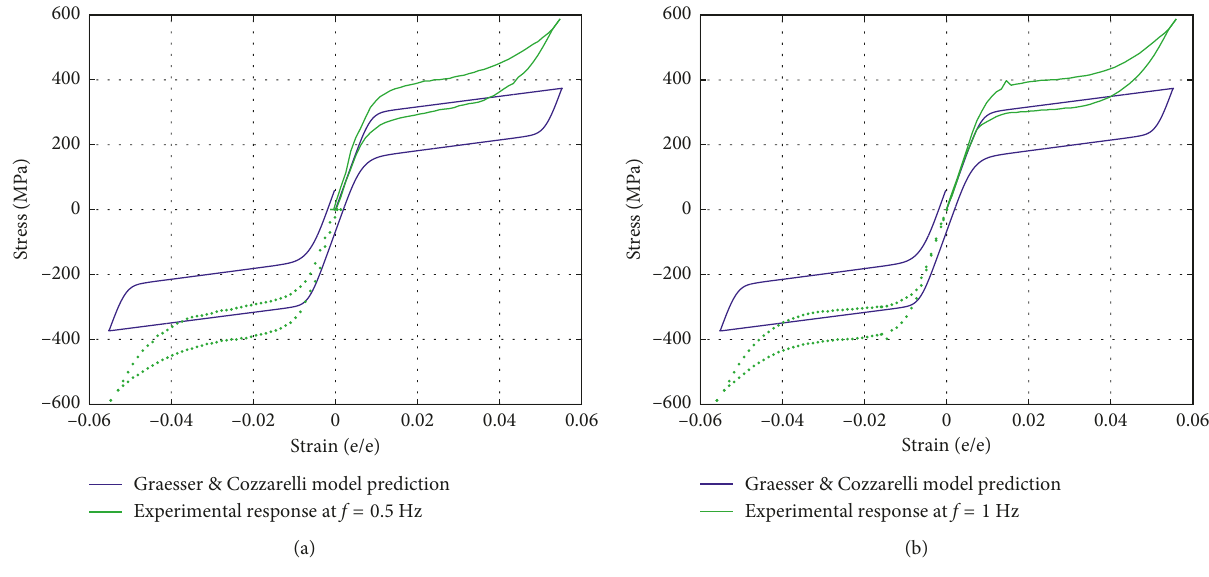
Figure 6: Comparison of Graesser – Cozzarelli model prediction to experimental response at (a) f � 0.5Hz and (b) f �